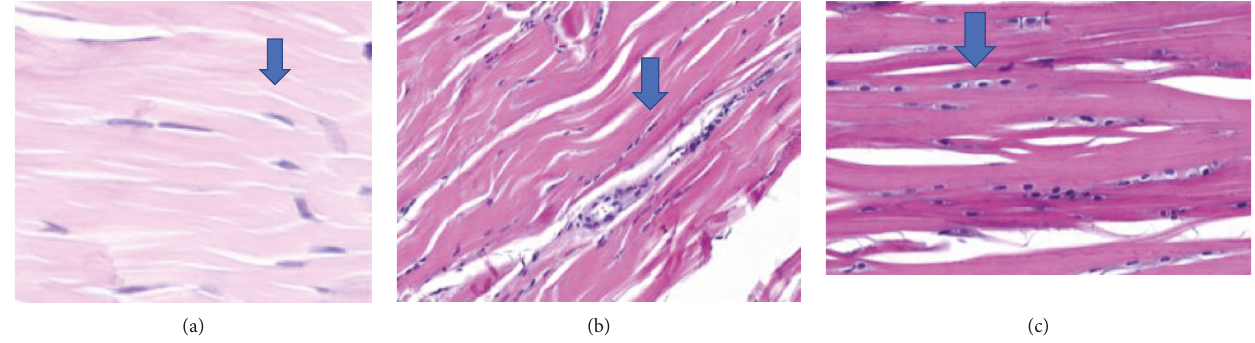
Figure 6: Enlarged images showing variations in the tenocytes, from linear and sparse to rounded and signi fi cantly increased. Table 9: Analysis of tenocyte density. Table 10: Analysis of the percentage of type I collagen in each Groups Tenocytes density